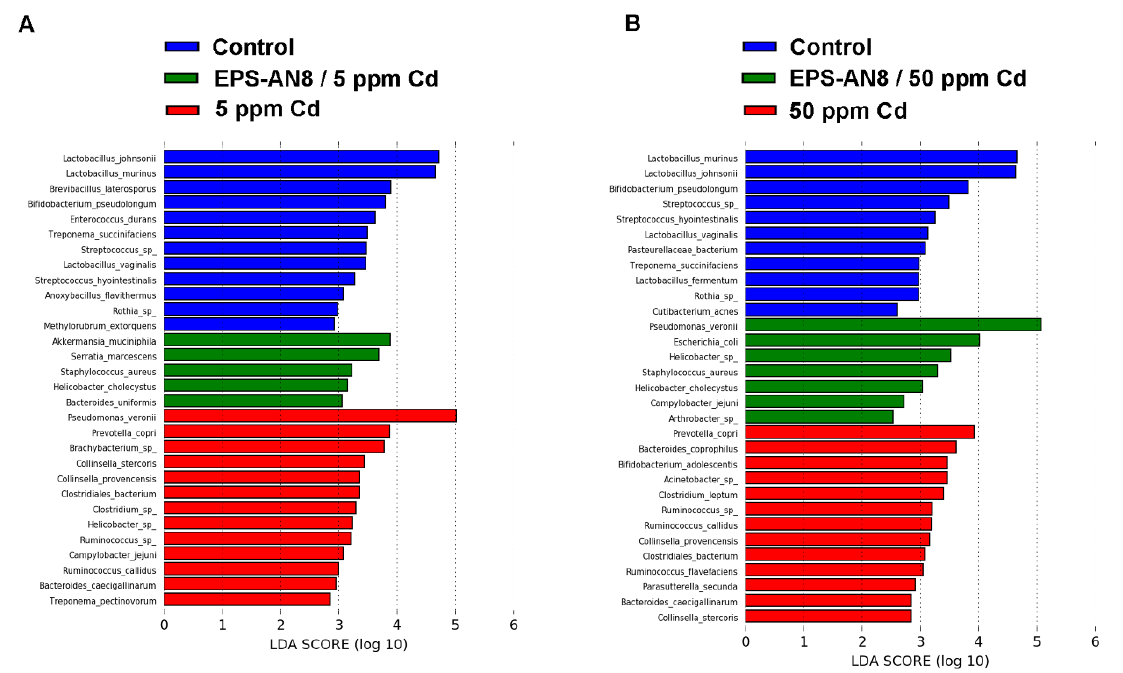
Figure 7. Graphical display of species between groups given by linear discriminant analysis effect size (LEfSe) of gut microbiota for lower ( A ) and higher ( B ) dose of